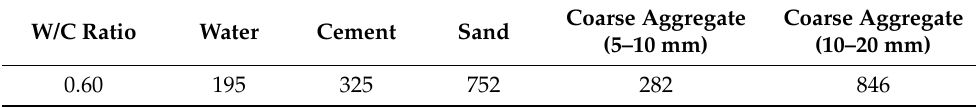
Table 2. Mix proportions of the control concrete (kg/m 3